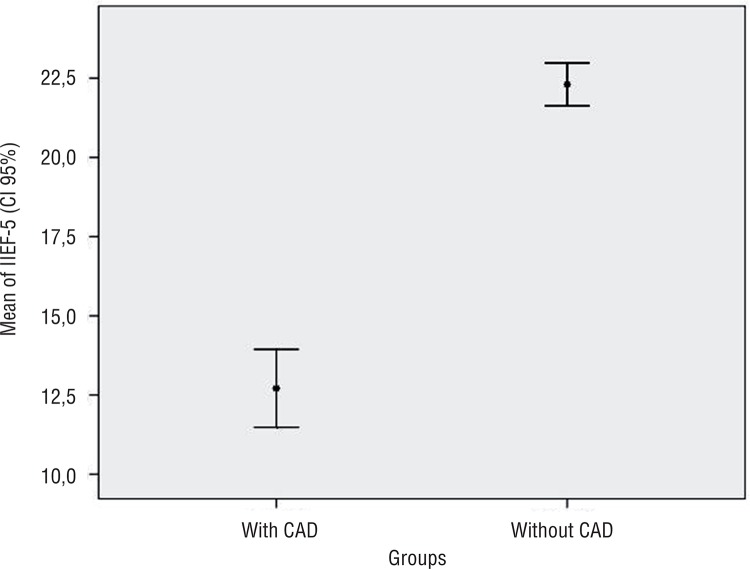
IIEF-5 versus Coronary Artery Disease